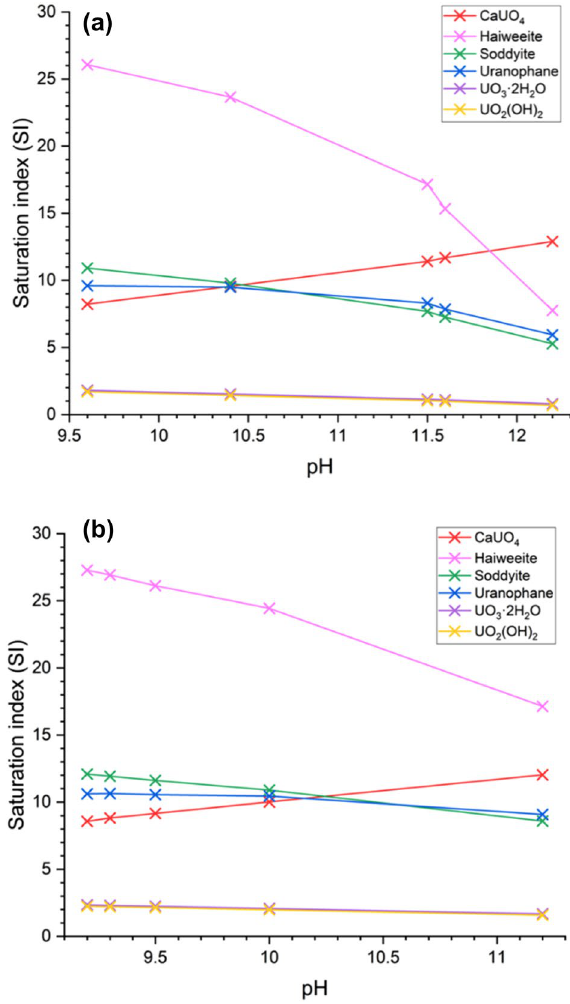
Figure 2. Saturation index estimations for U(VI)-containing phases. For ( a ) 0.5 mM U(VI)-contacted and ( b ) 10 mM U(VI)-contacted C–S–H systems at pH values associated with the starting Ca/Si